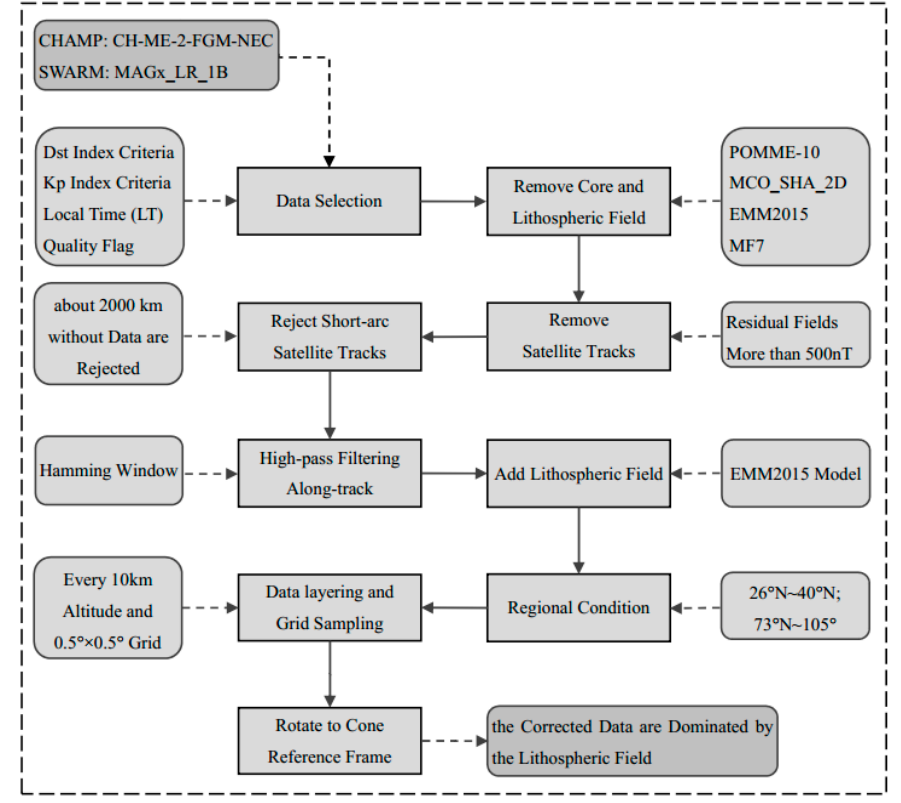
Figure 3. Flow chart showing the sequence of processing steps to separate the lithospheric field contributions from the satellite magnetic data.